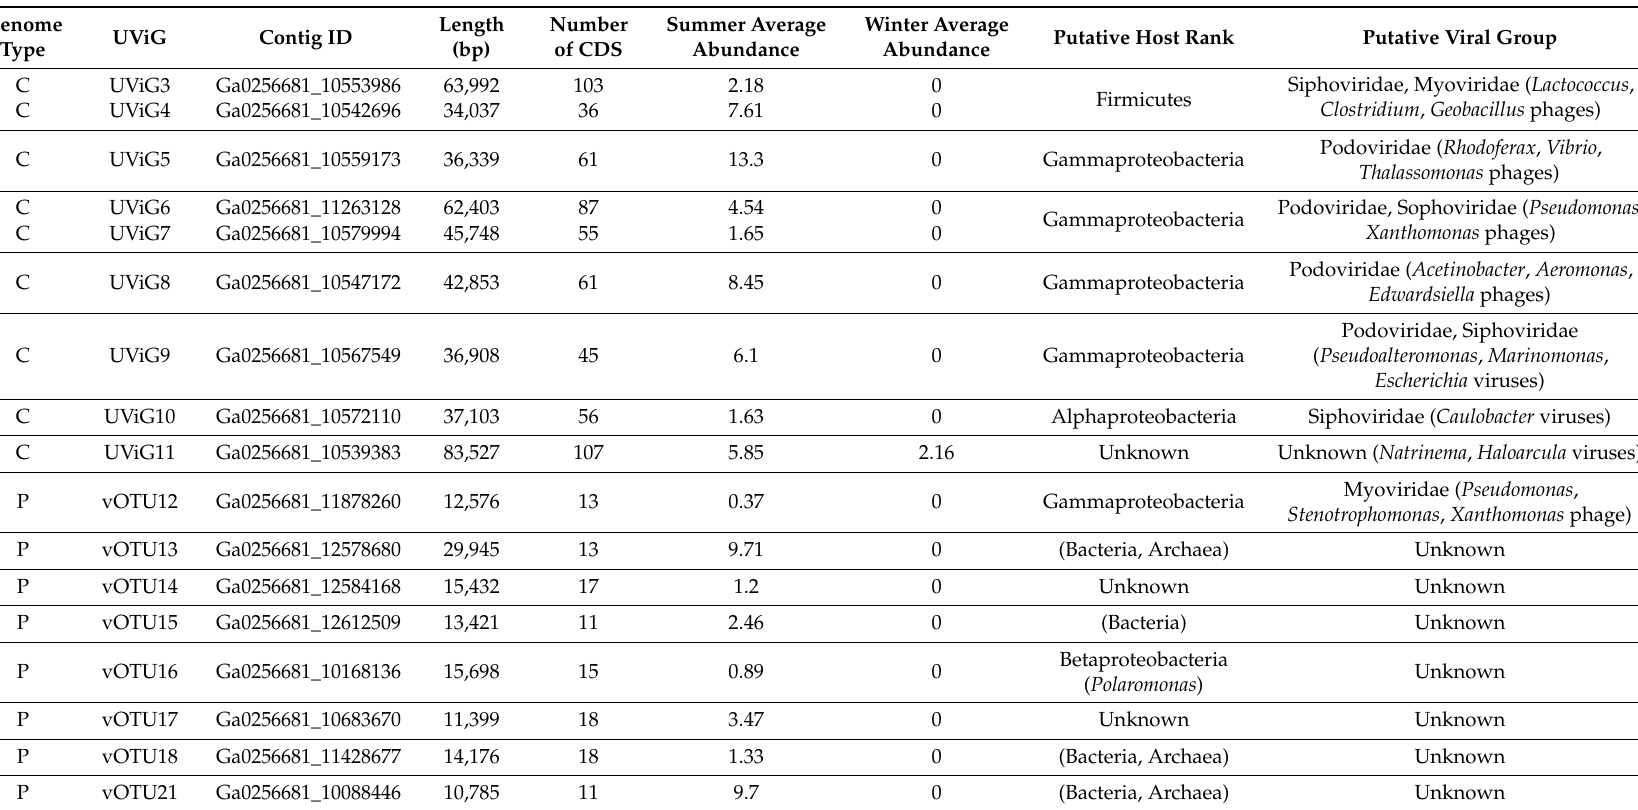
Table 2. Potential viral and host taxonomy for circular viral Uncultivated Viral Genomes (UViGs) and integrated prophages identified from SAS2A metagenomes. Putative host rank was identified by ViPTree proteomic analyses for circular genomes through closely related genomes (within the same clade) (Supplementary Figure S2) and rRNA 16S extracted genes for prophages. Viral taxonomy was inferred from ViPTree. For prophages, BLASTx hits are presented for similar hits, when available. UViGs are identified as either circular (C) or prophages (P), length is given in base pairs (bp) and CDS are protein-coding features. Normalized abundance was averaged across triplicates within a